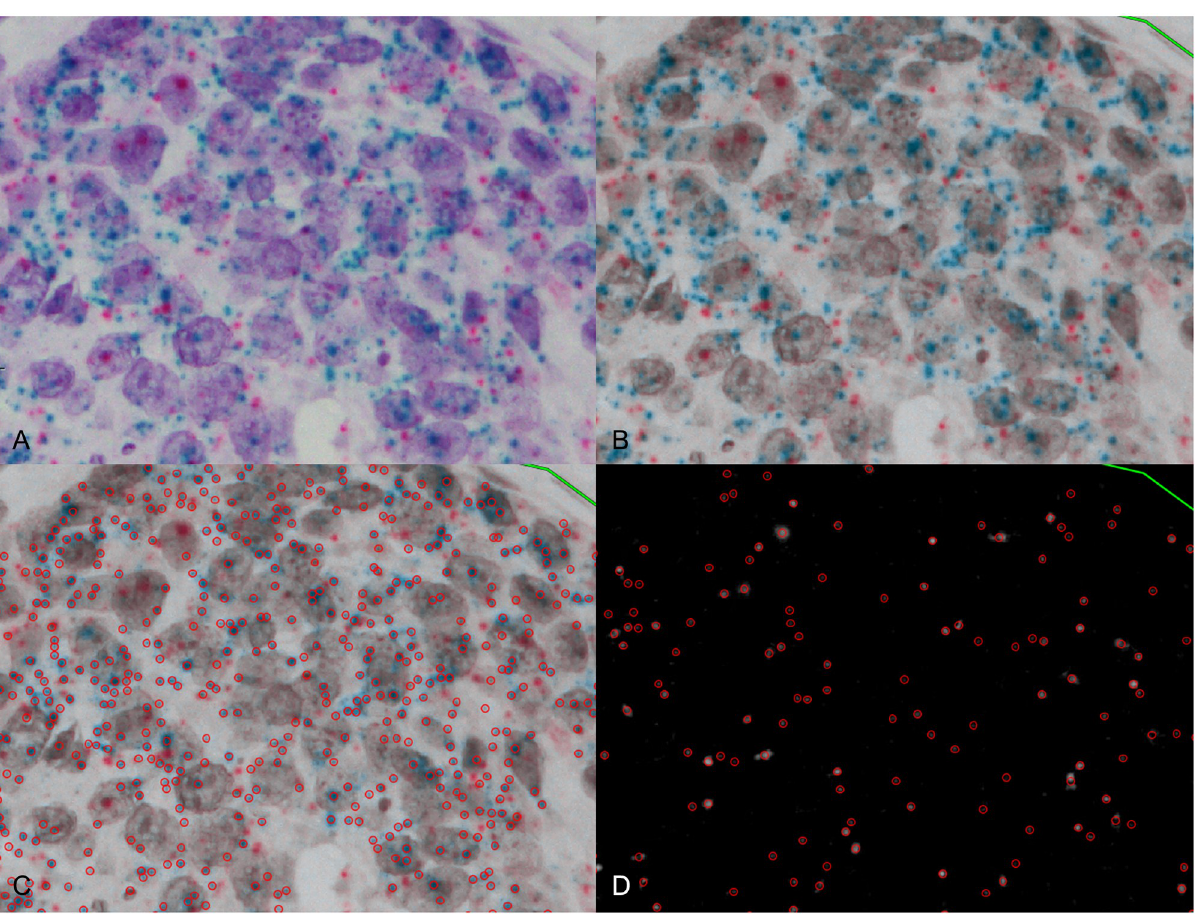
Fig 2. Example of analyzing RNA-ISH images. (A) Original image of RNA-ISH. Blue dots ( HER2 ) and red dots ( POLR2A ) were observed. (B) Blue dots and red dots were observed in Tritanope filtered image. (C) Blue dots are recognized and enumerated by spot detector of open-source program. (D) Red dots are recognized and enumerated by spot detector of open-source